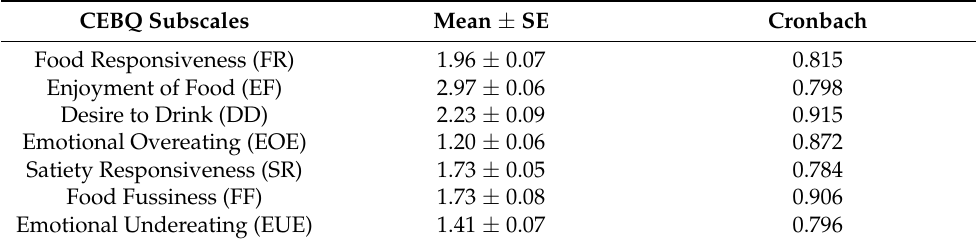
Table 1. Factor structure and internal reliability of the child eating behavior questionnaire.